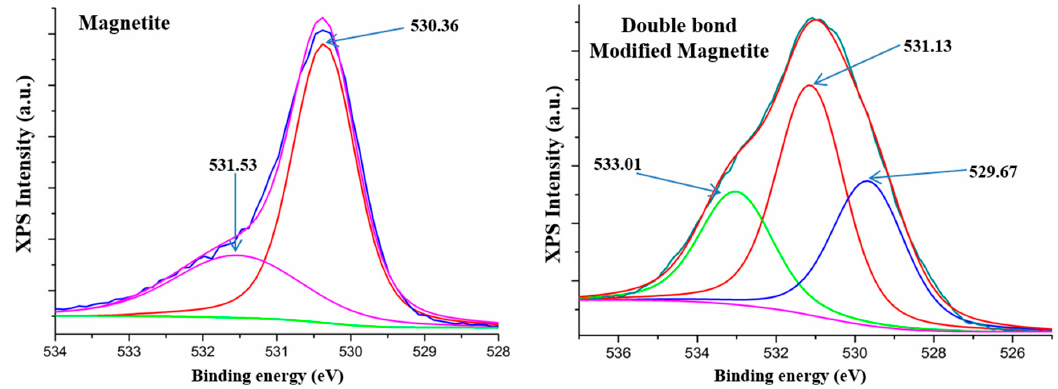
Figure 5. XPS spectra of magnetite and double bond modified magnetite.